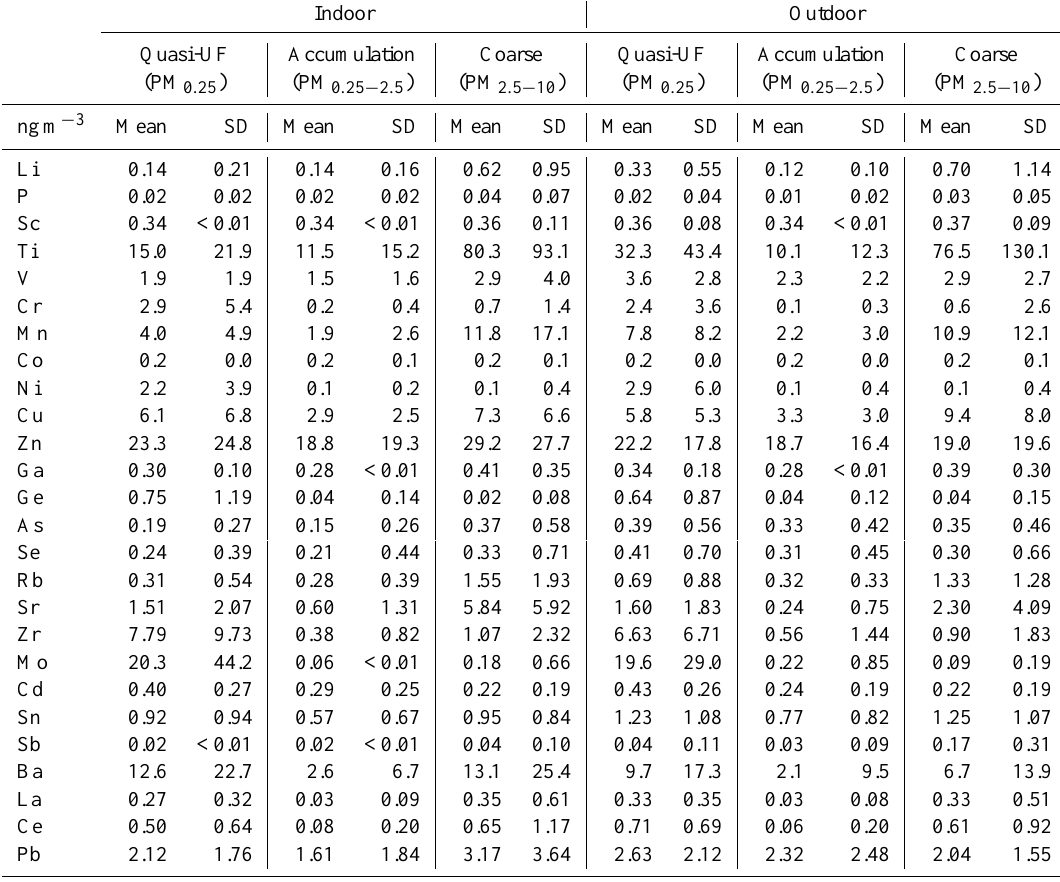
Table 1b. Mean concentration and standard deviation (SD) for trace elements (in ngm − 3 ) including metals in 39 schools in Barcelona. Indoor Outdoor Quasi-UF Accumulation Coarse Quasi-UF Accumulation